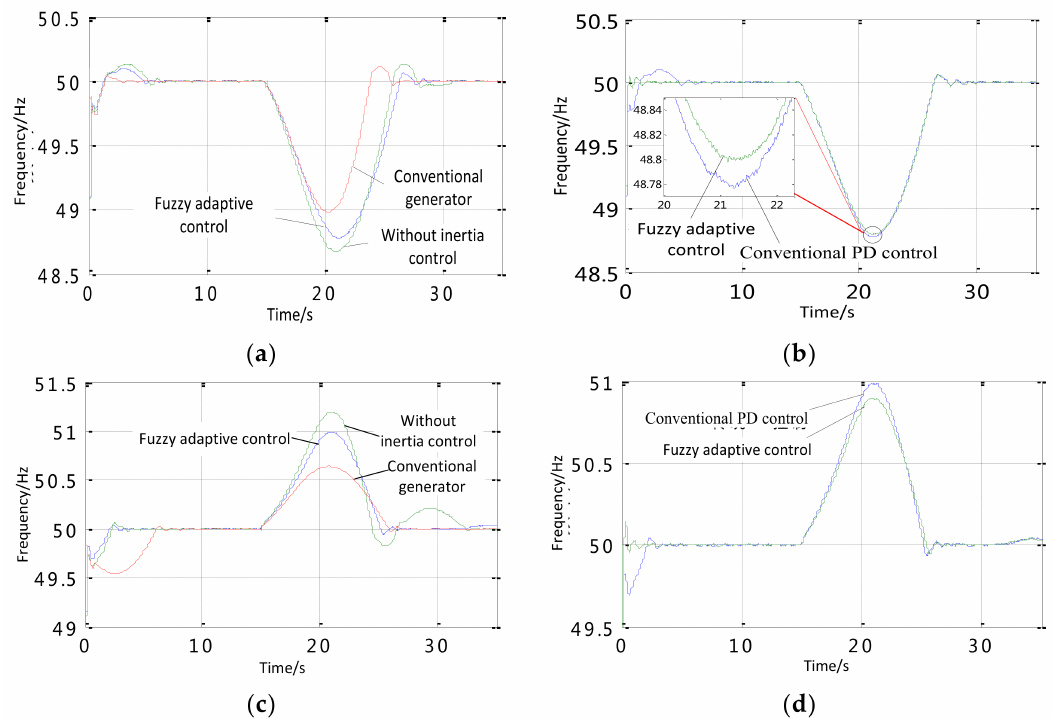
Figure 5. The frequency’s response curve at the load sudden increase and decrease. ( a ) The frequency’s response curve of fuzzy adaptive control, conventional generator and without inertia control with load increase; ( b ) The frequency’s response curve of fuzzy adaptive control and conventional PD control with load increase; ( c ) The frequency’s response curve of fuzzy adaptive control, conventional generator and without inertia control with load decrease; and ( d ) The frequency’s response curve of fuzzy adaptive control and conventional PD control with load decrease